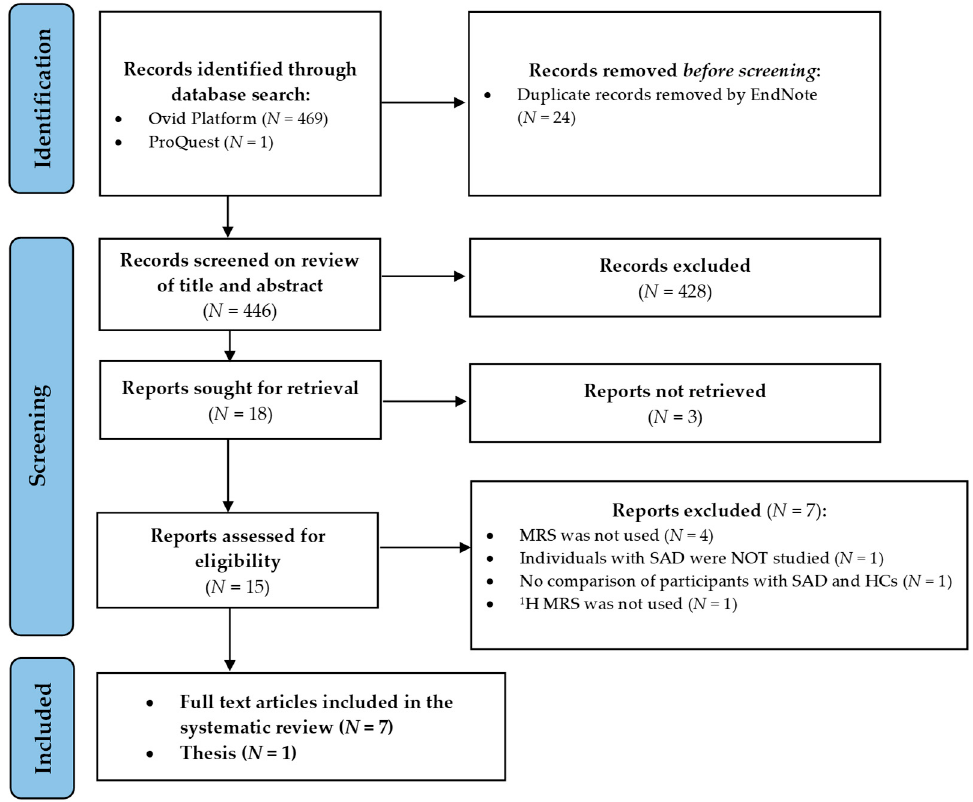
Figure 2. Retrieval flowchart indicating how the data were obtained for systematic review. Abbre- viations: N , number of publications; MRS, Magnetic Resonance Spectroscopy; SAD, Social Anxiety Disorder; HC, healthy controls; 1 H MRS, Proton Magnetic Resonance